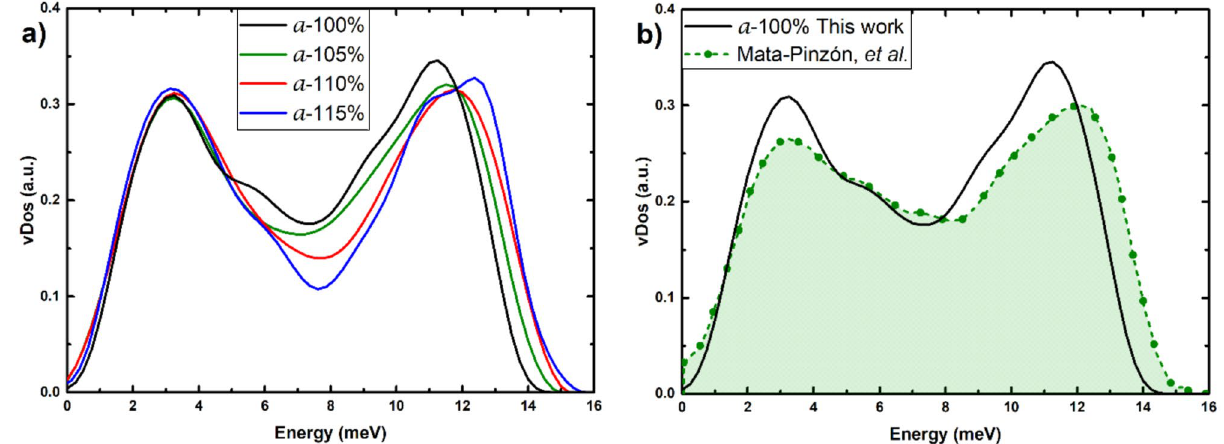
Figure 6. vDoS for ( a ) the non-expanded and expanded amorphous structures, and for ( b ) 100% a-Bi compared to the simulations of Ref.